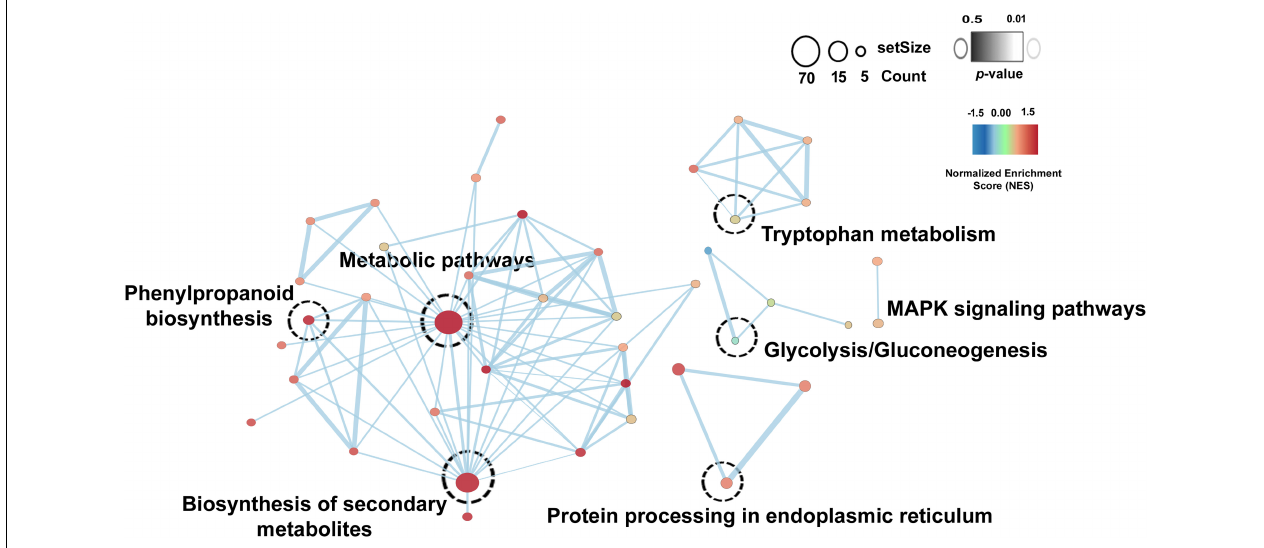
FIGURE 4 | Common enriched pathways in drought and salt dataset. Node color shows the normalized enrichment score (NES) from the core enrichment genes. A positive score (red) shows gene set enrichment at the top of the ranked list, and a negative score (blue) indicates gene set enrichment at the bottom of the ranked list. The color of the border represents the p -value of the enriched pathway.